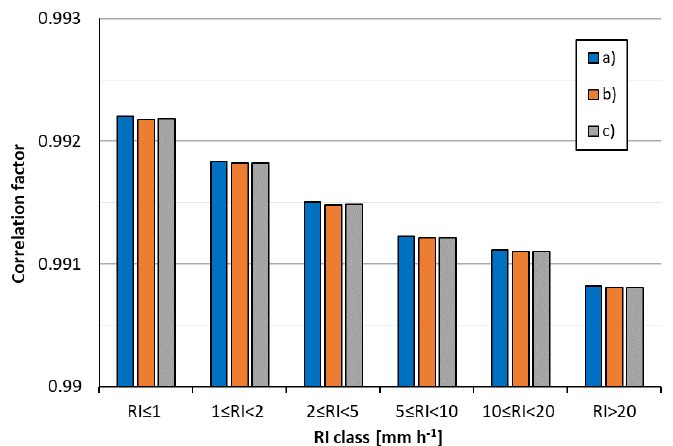
Figure 9. Correlation factors between the raw CE values and the CE curves obtained, for each RI class, under step ( a ) (blue), ( b ) (orange) and ( c ) (grey).